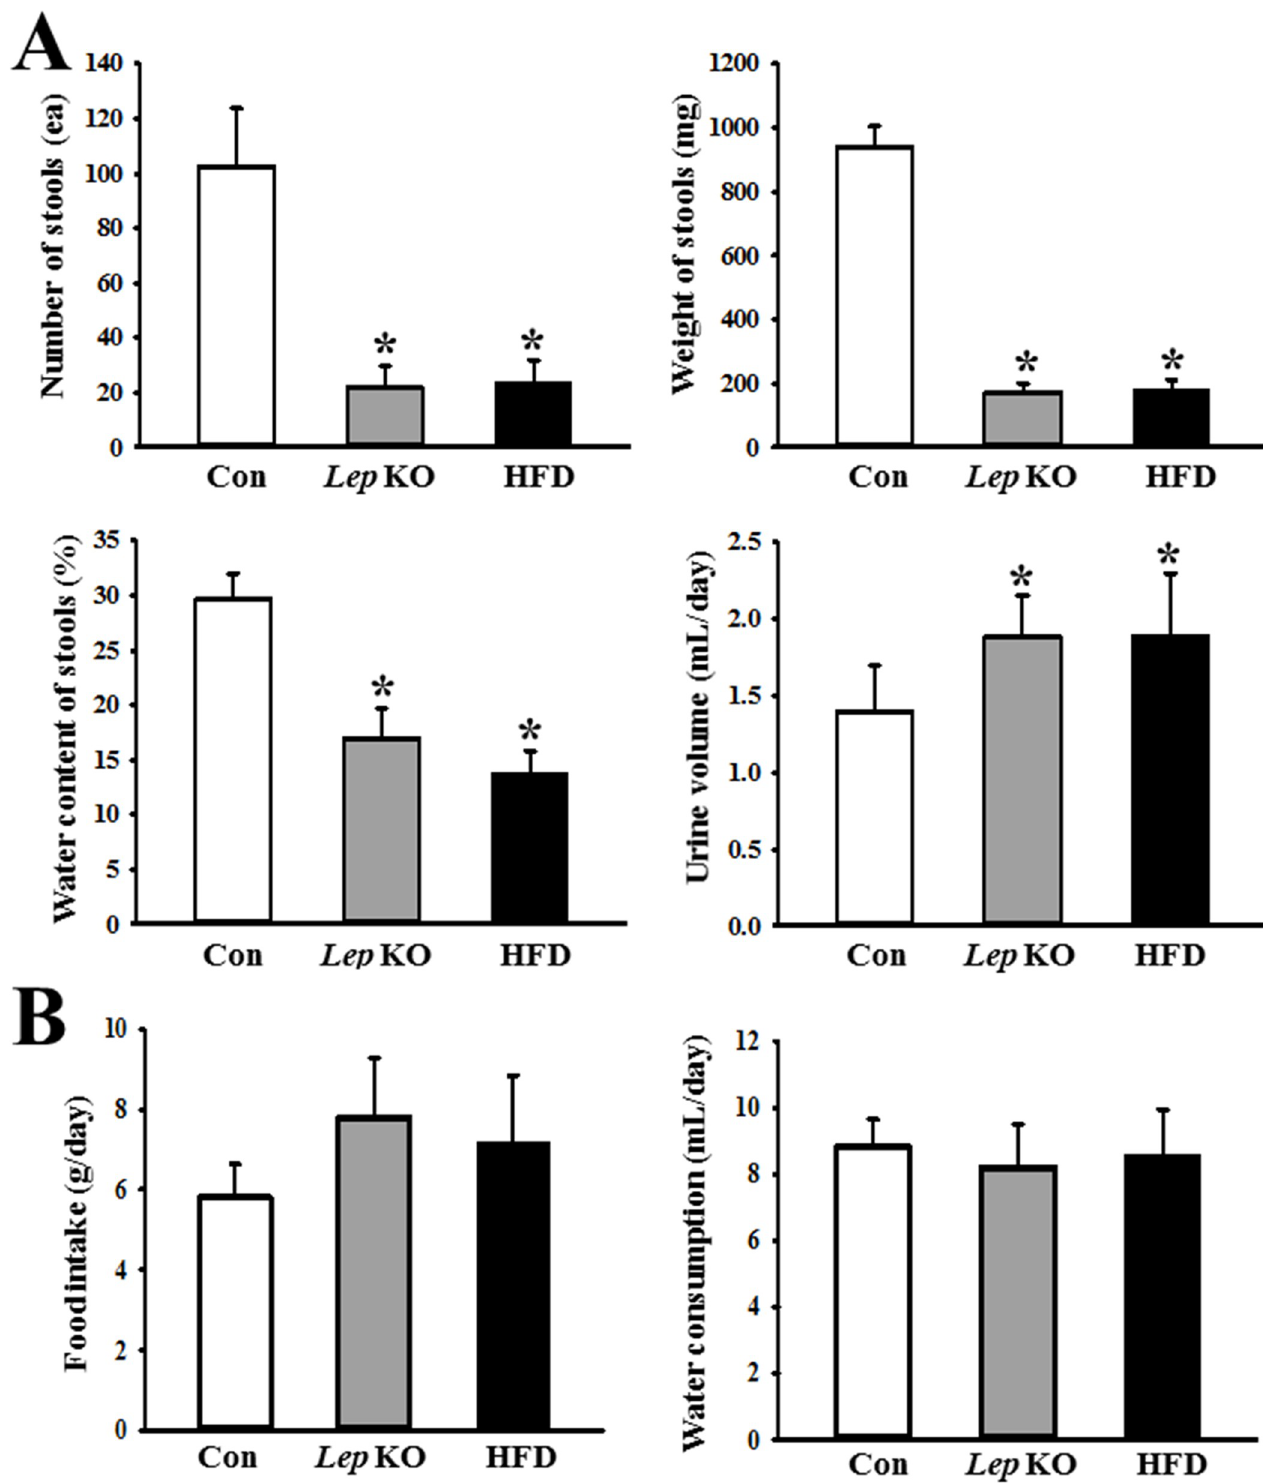
Fig 2. Excretion parameters and feeding behavior. (A) The levels of the four excretion parameters, including number of stools, the weight of stools, water contents of stool, and urine volume, were measured from mice bred in a metabolic cage. Five to six mices per group were used for the stool and urine sample collection, and each parameter was assayed in duplicate. (B) The food intake and water consumption were also calculated using the amount of feed (water) supplied and the amount of feed (water) remaining. The data are reported as the mean ± SD. � indicates p < 0.05 compared to the Con group. Abbreviations: Con, Control group; Lep KO, Leptin knockout mice; HFD, High fat diet. https://doi.org/10.1371/journal.pone.0276445.g002 PLOS ONE | https://doi.org/10.1371/journal.pone.0276445 December22,